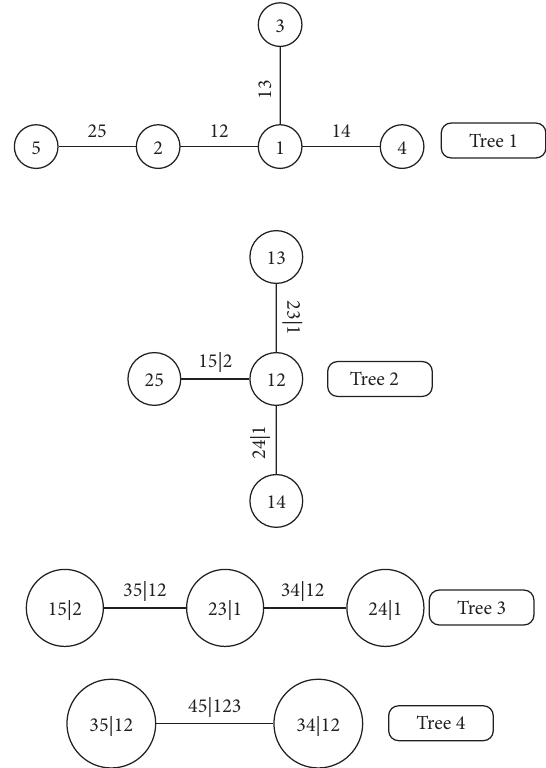
Figure 3: Full R -vine copula mixture model. 5-dimensional, 4 trees, 10 edges, and 30 parameters.